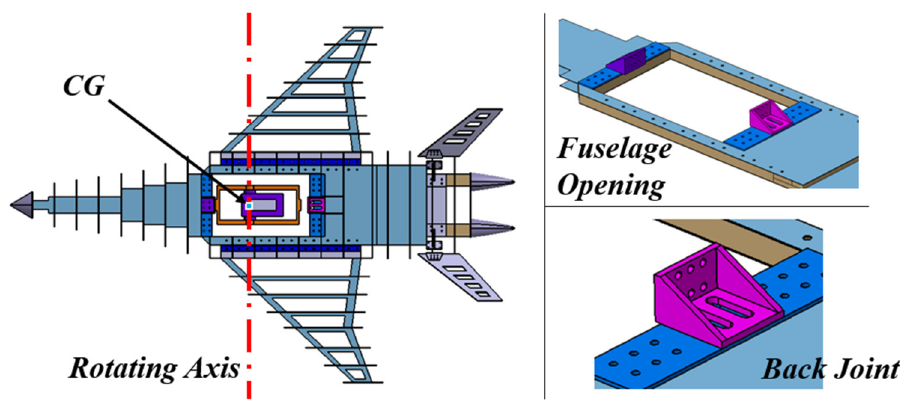
Figure 10. Structure design of the aircraft.